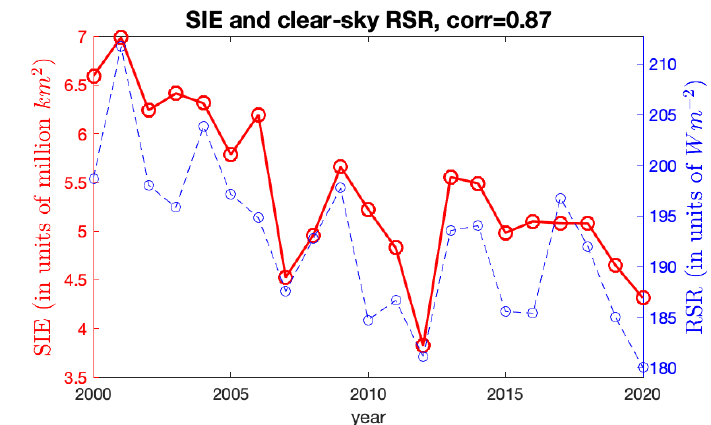
Figure 5. The time series of spatially averaged CS-RSR data for June (blue dashed line) versus the Arctic SIE data for September (red solid line). The averaged values of RSR are taken over all RSR observations in the Arctic region (latitudes ≥ 60 ◦